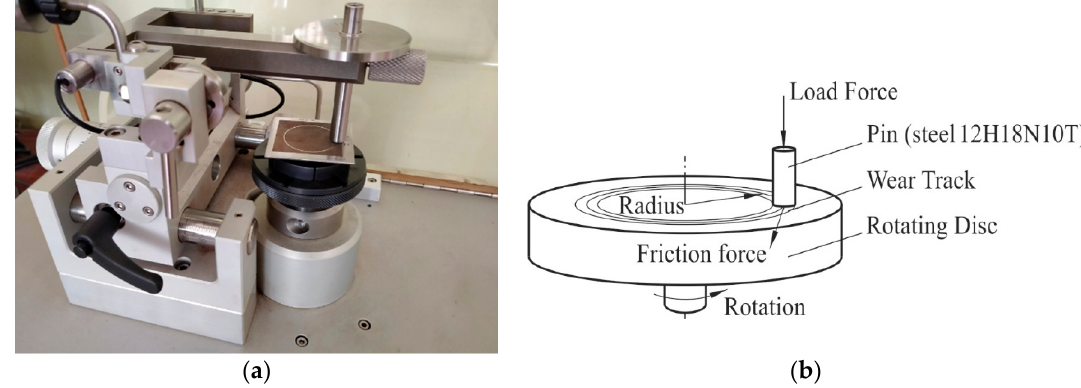
Figure 1. Determination of friction coefficient: ( a ) photo of CSM Instruments SA tribometer with a test sample and ( b ) the test scheme.